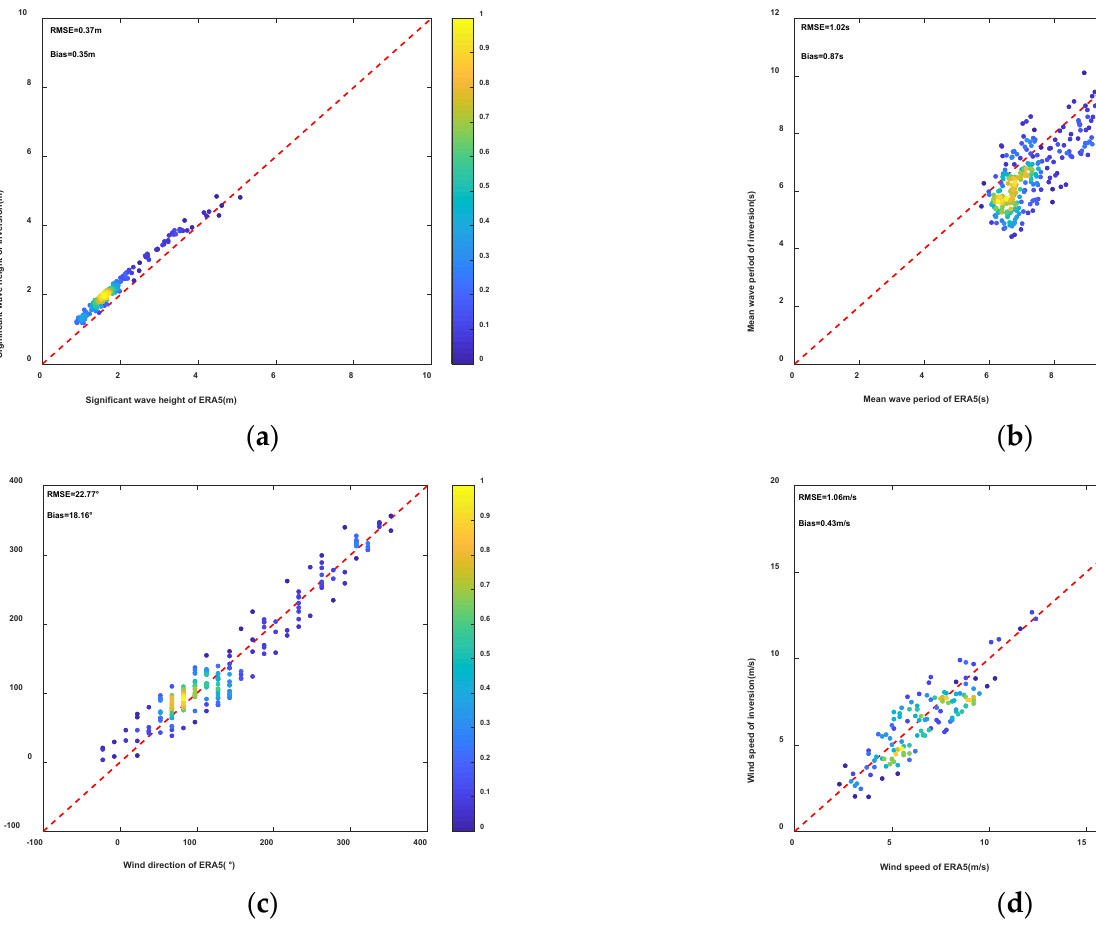
Figure 8. Comparison of the inversion results with the ECMWF ERA5 data: ( a ) Significant wave height; ( b ) Mean wave period ( c ) Wind direction; ( d ) Wind